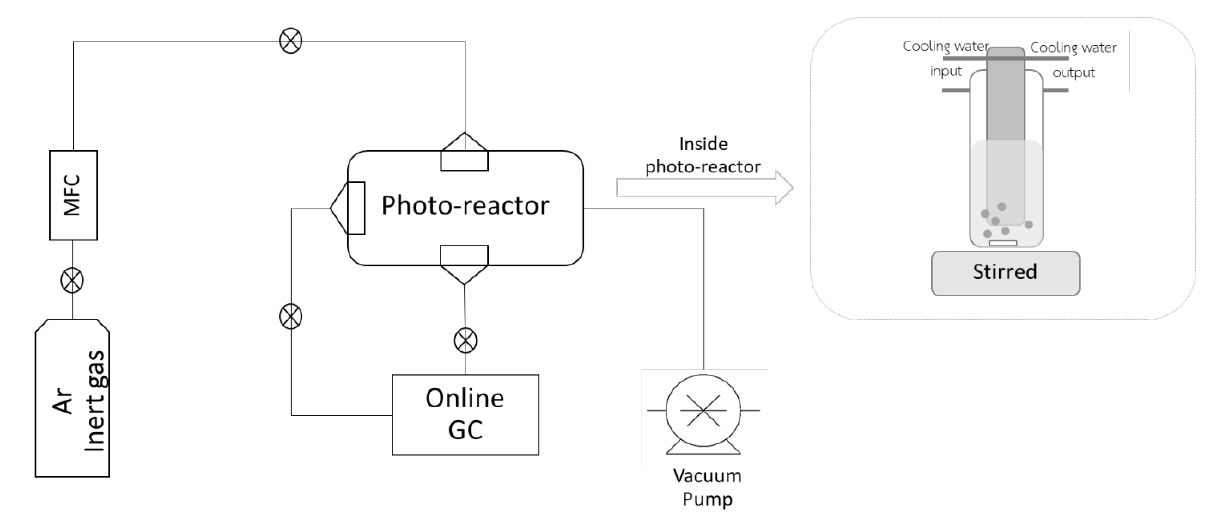
Figure 7. The schematic diagram of the experimental photoreactor.